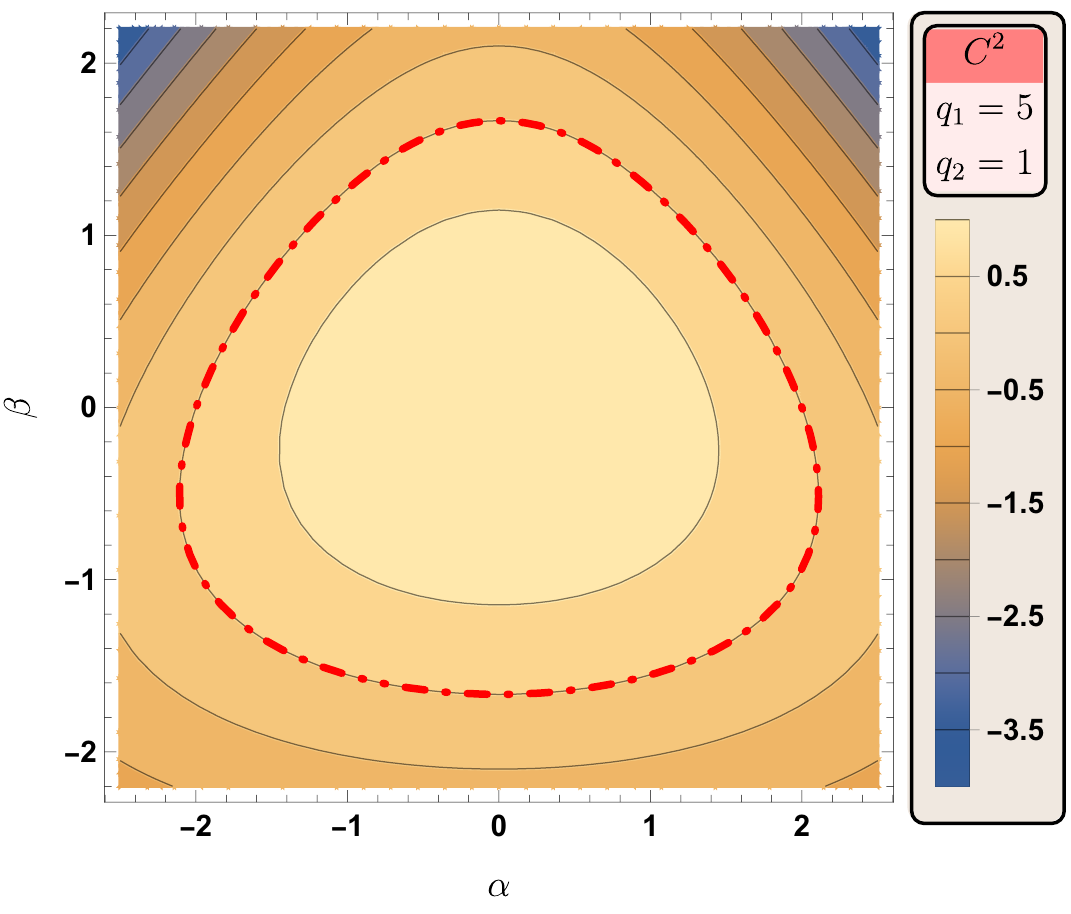
Figure 3 . Plot of C 2 , (6.3), for q 1 = 5 , q 2 = 1 , as a function of α and β . The red dashed-dotted lines indicates the C = 0 contour, which encloses the region of positive values. C 2 determines the size of the ψ circle at infinity, in the asymptotically AdS 3